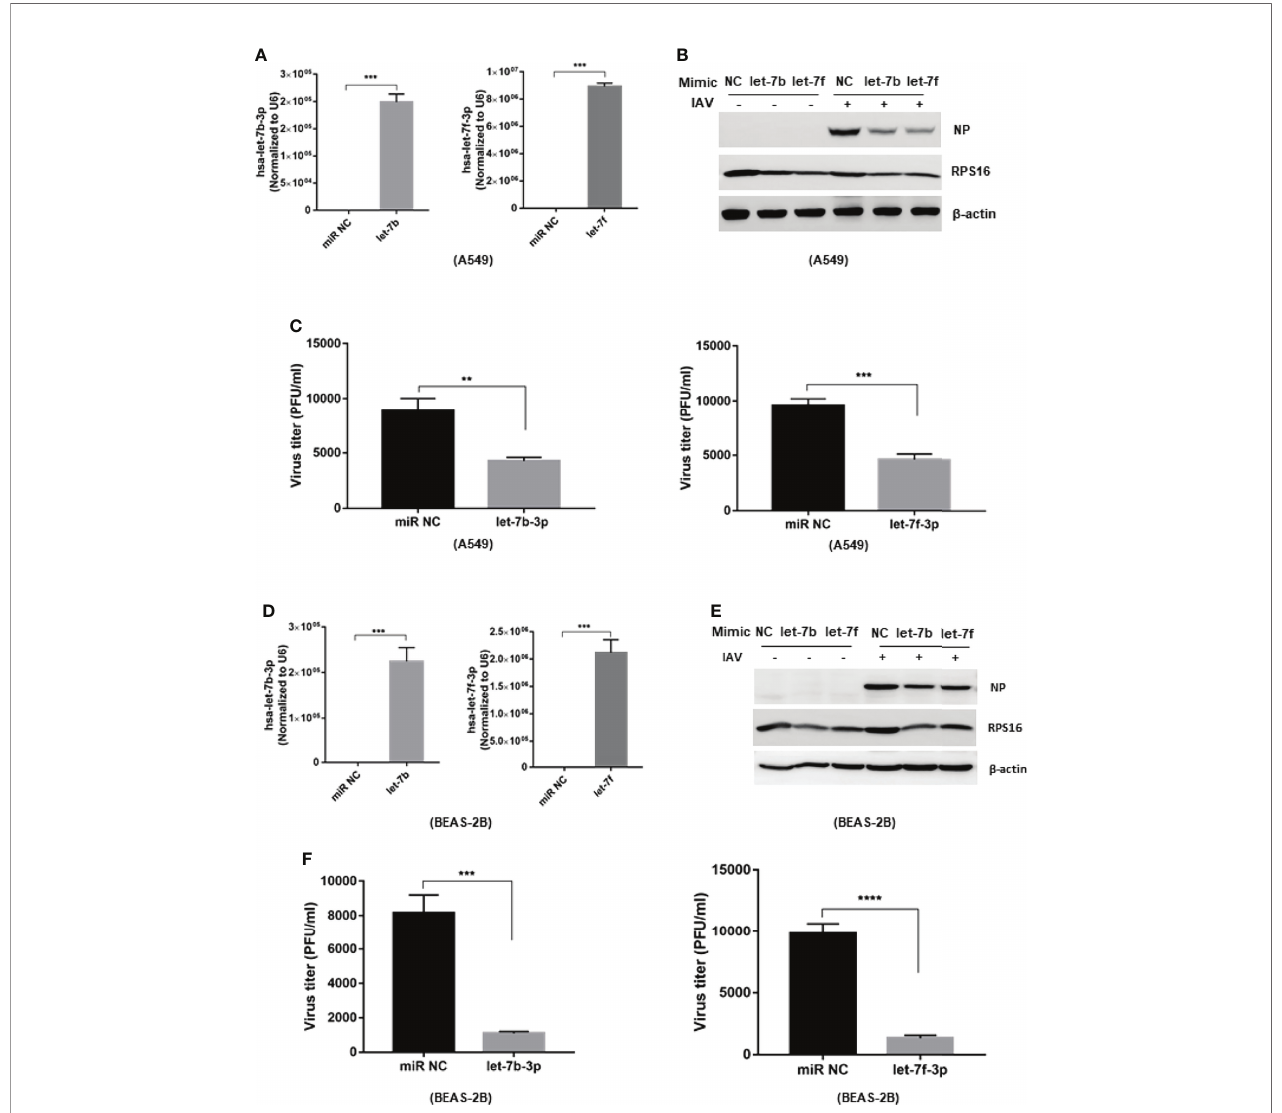
FIGURE 2 | Over-expression of let-7b and let-7 inhibits in fl uenza A virus infection to the host cell. The mimic of hsa-let-7b-3p and hsa-7f-3p (50nM) were transfected to A549 cell, the expression of let-7b-3p and let-7f-3p was detected by RT-PCR (A) . At 48h post transfection, the cells were infected with in fl uenza A/ WSN/1933 virus at 0.1 of MOI; (B) the in fl uenza NP protein expression were measured by western blotting at 24h post infection; (C) the new born virus titer in the supernatants was tested by plaque forming assay and calculated. (D) The expression of let-7b-3p and let-7f-3p in BEAS-2B cell transfected with the mimic of hsa- let-7b-3p, hsa-7f-3p (50nM) for 48h. At 48h post transfection, the cells were infected with in fl uenza A/WSN/1933 virus at 0.1 of MOI; (E) the in fl uenza NP protein expression were measured by western blotting at 24h post infection; (F) the new born virus titer in the supernatants was tested by plaque forming assay and calculated. Data were shown as mean ± SD (** p < 0.01, *** p <